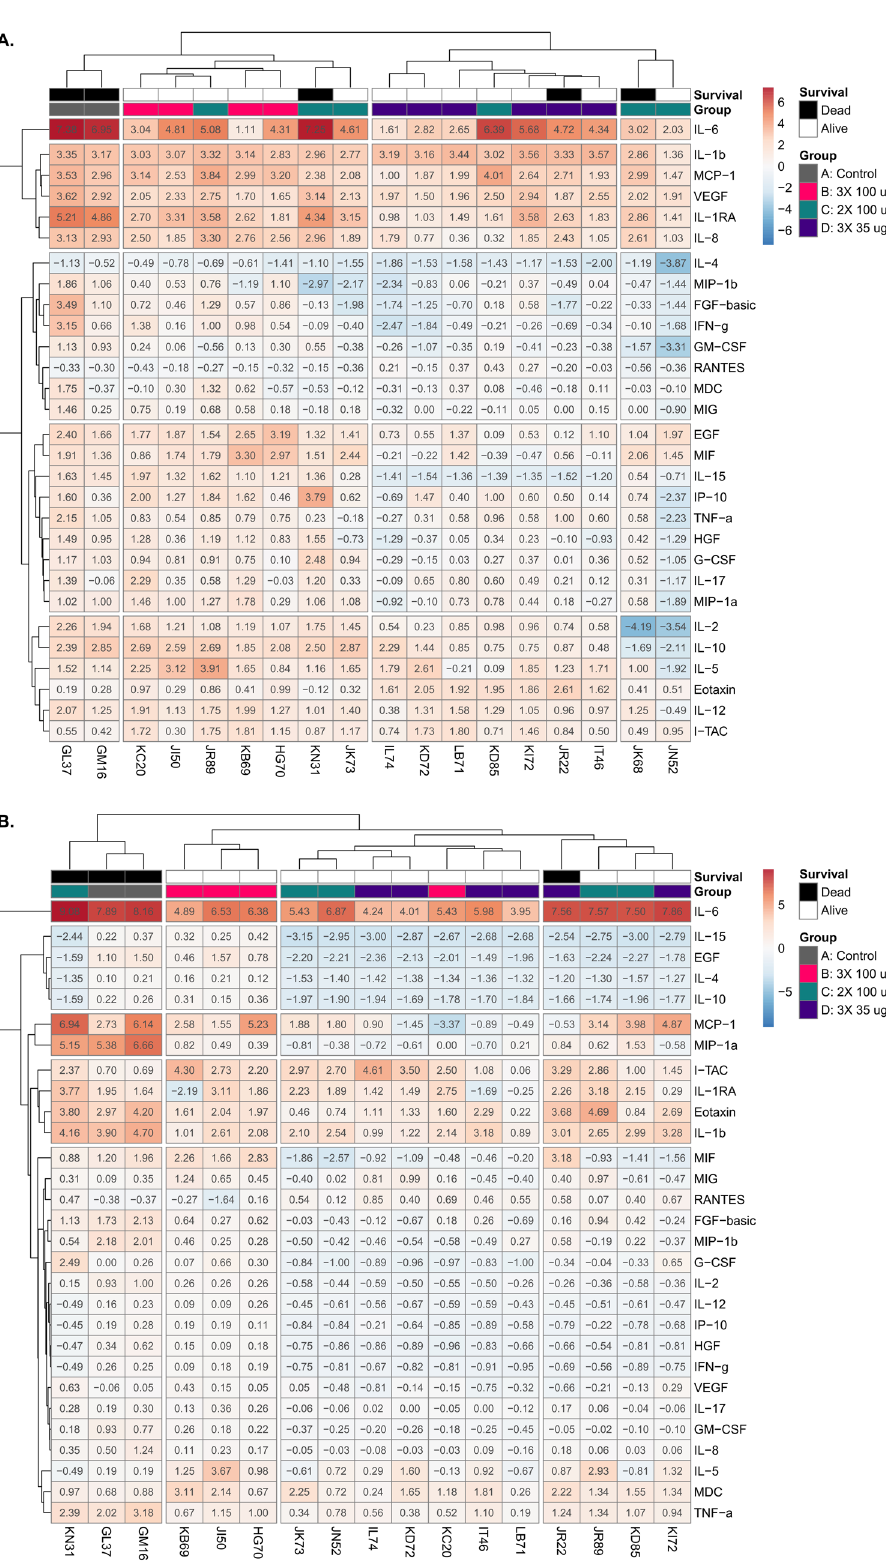
Fig. 3 In fl ammatory cytokine responses in sera and BAL fl uids of control and RiVax-vaccinated Rhesus macaques following RT exposure. Heatmap (log 2 -transformed fold change) of 29-plex of cytokines, chemokines, and growth factors in A serum and B BAL fl uids collected before and 24 h after RT challenge for each animal. Each column represents an animal, with the topmost row showing decedents in black and survivors in white. The next row depicts vaccine group membership (A – D), as designated in the legend. The dendrograms on the top and left of each plot show the results of unsupervised HC, which grouped of fold changes animals and cytokines with the most similar changes in expression. Each cell is scaled from red to blue, as described by the bar on the